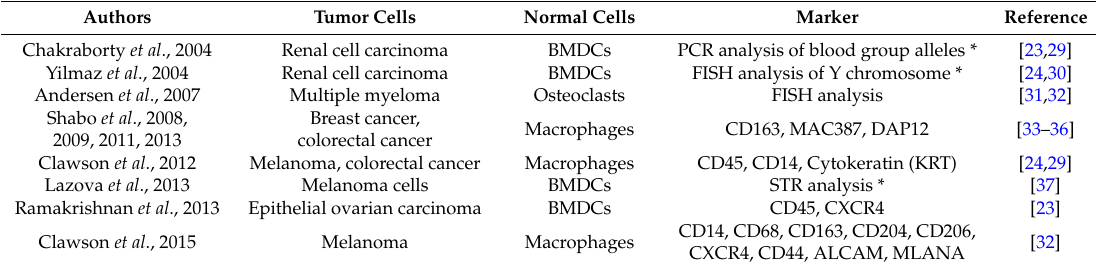
Table 1. Identification of tumor hybrid cells in human